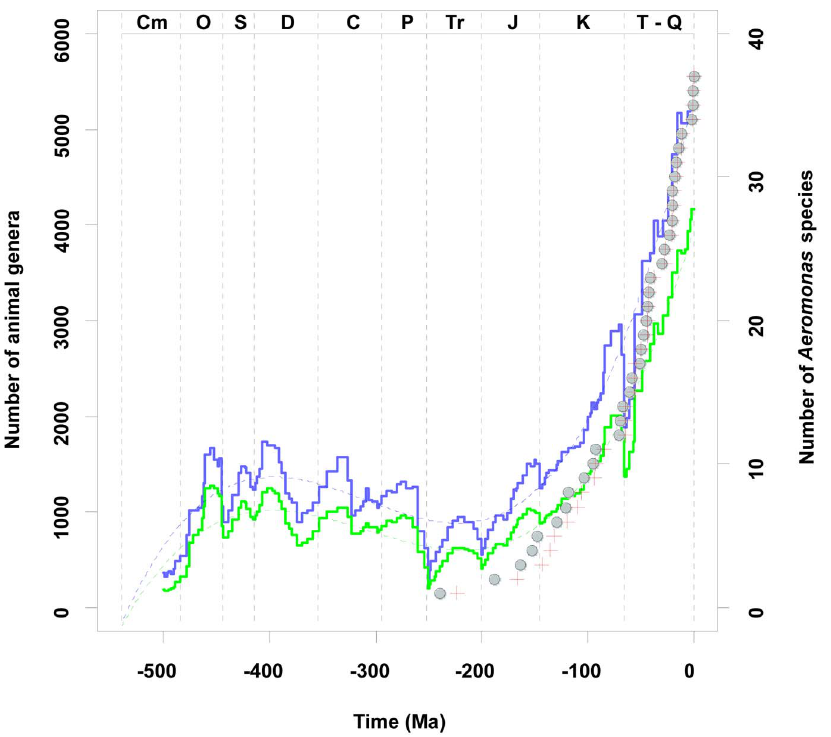
Figure 9. Diversification of Aeromonas compared with the number of animal genera versus time. Diversification of Aeromonas determined by Bayesian (circles) and MLA (crosses) approaches, compared with the number of animal genera versus time obtained from Sepkoski’s compendium, converted to the 2004 Geologic Time Scale [95], [96]. The blue line represents the total number of animal genera while the green line shows the same data with single occurrence and poorly dated genera removed. Dashed lines indicate polynomial fits to data. Abbreviations: Cm; Cambrian, O; Ordovician, S; Silurian, D; Devonian, C; Carboniferous, P; Permian, Tr; Triassic, J; Jurassic, K; Cretaceous, and T-Q; Tertiary-Quaternary.